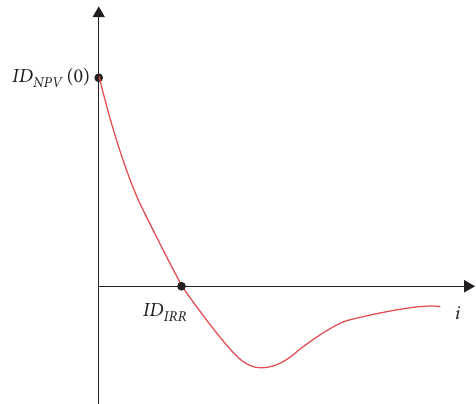
Figure 4: NPV curve of transnational investment project with multiple investments.